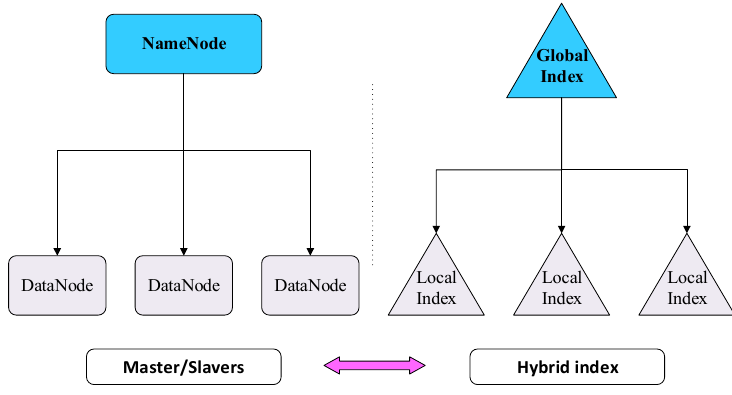
Figure 5. The distributed R-tree index.